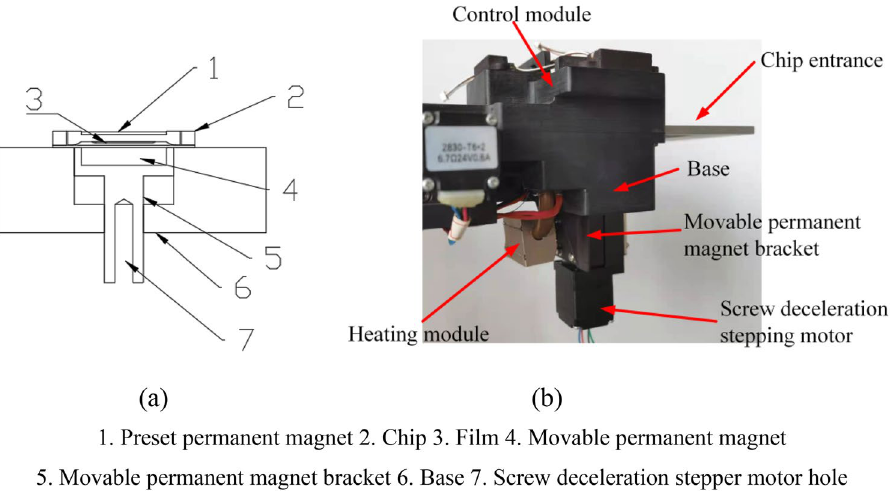
Figure 5. Magnetic beads mixing motion control structure. ( a ) Structural schematic diagram. ( b ) Motion